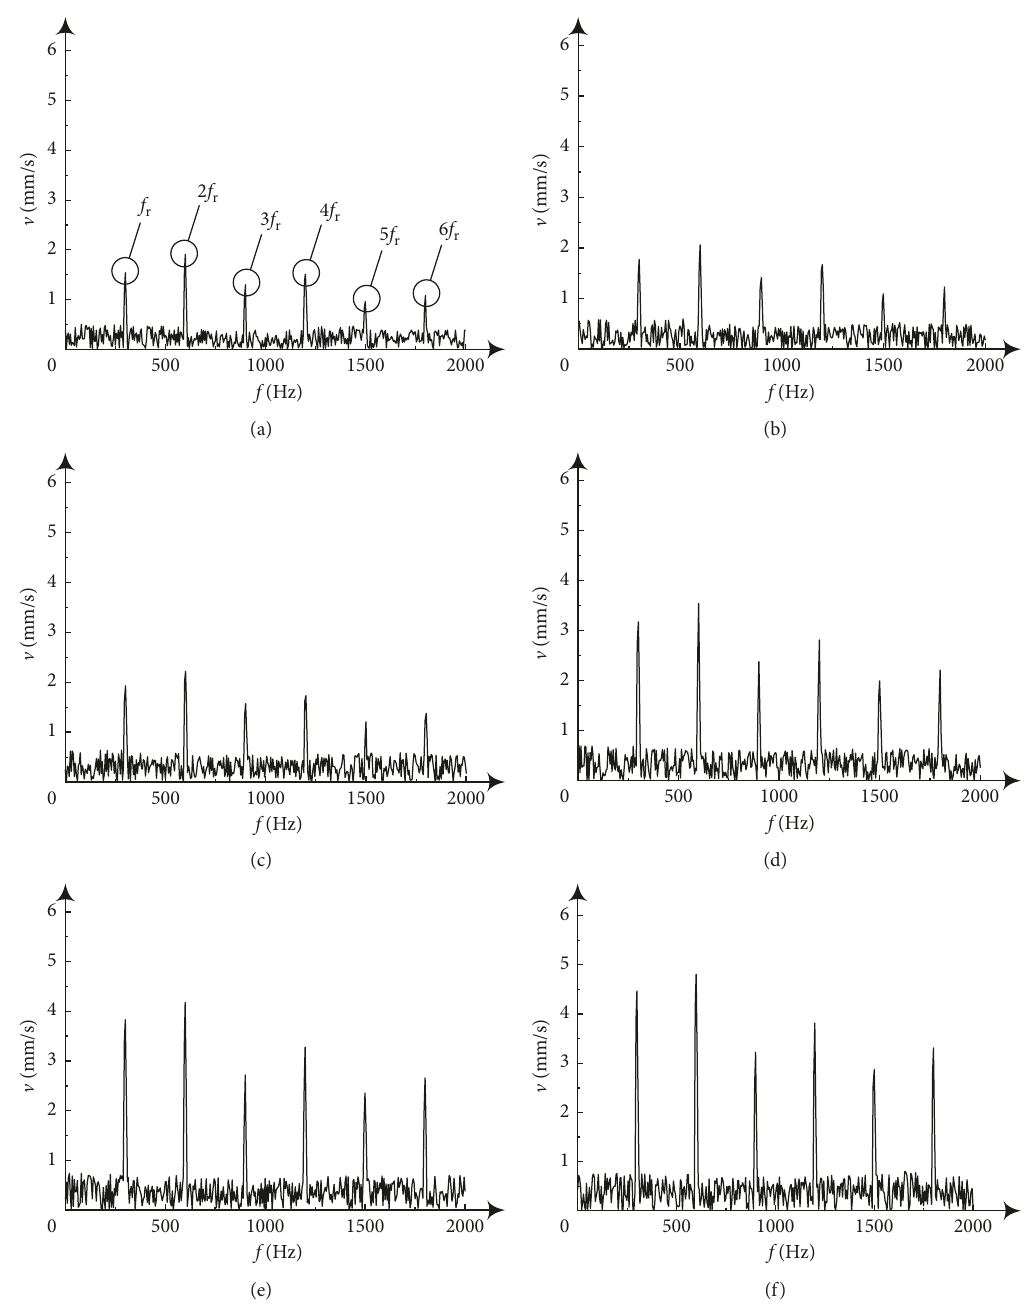
Figure 9: Vibration of the outer ring at (a) T � 100K, (b) T � 200K, (c) T � 300K, (d) T � 400K, (e) T � 500K, and (f) T �